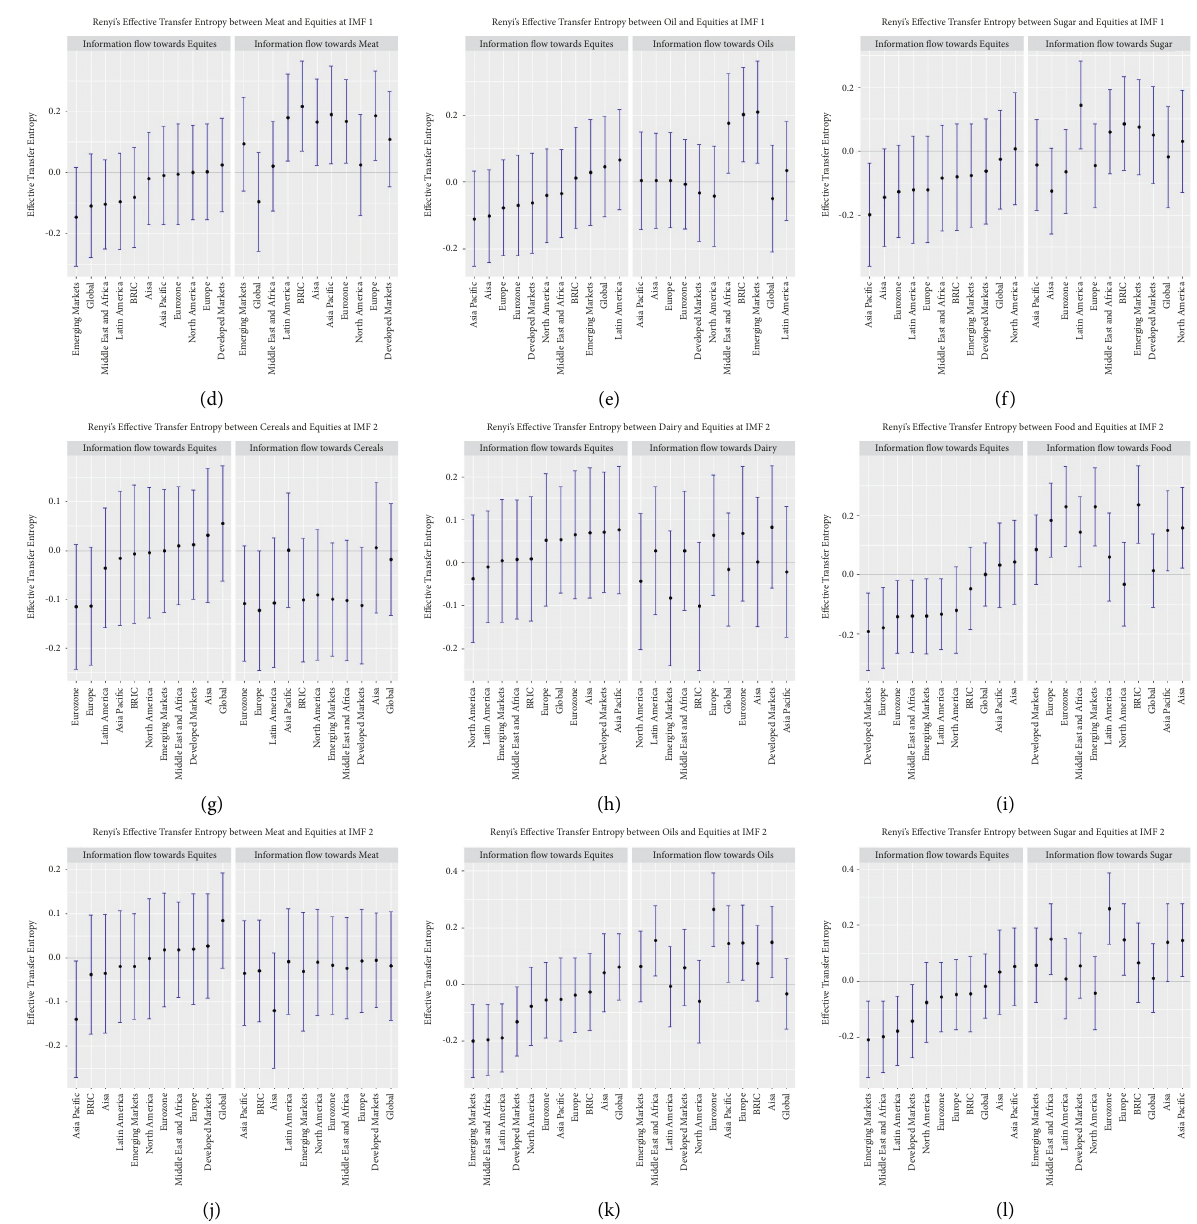
Figure 4: Transfer entropies in the short term. Notes: This figure presents the quantified information flow between the returns on world food commodity and regional equity markets at short-term scales (IMFs 1 and 2). (a) to (f), respectively, represent ETEs for cereals, dairy, food, meat, vegetable oil, and sugar indices against the regional equities for IMF1 with their corresponding IMF2 being (g) to